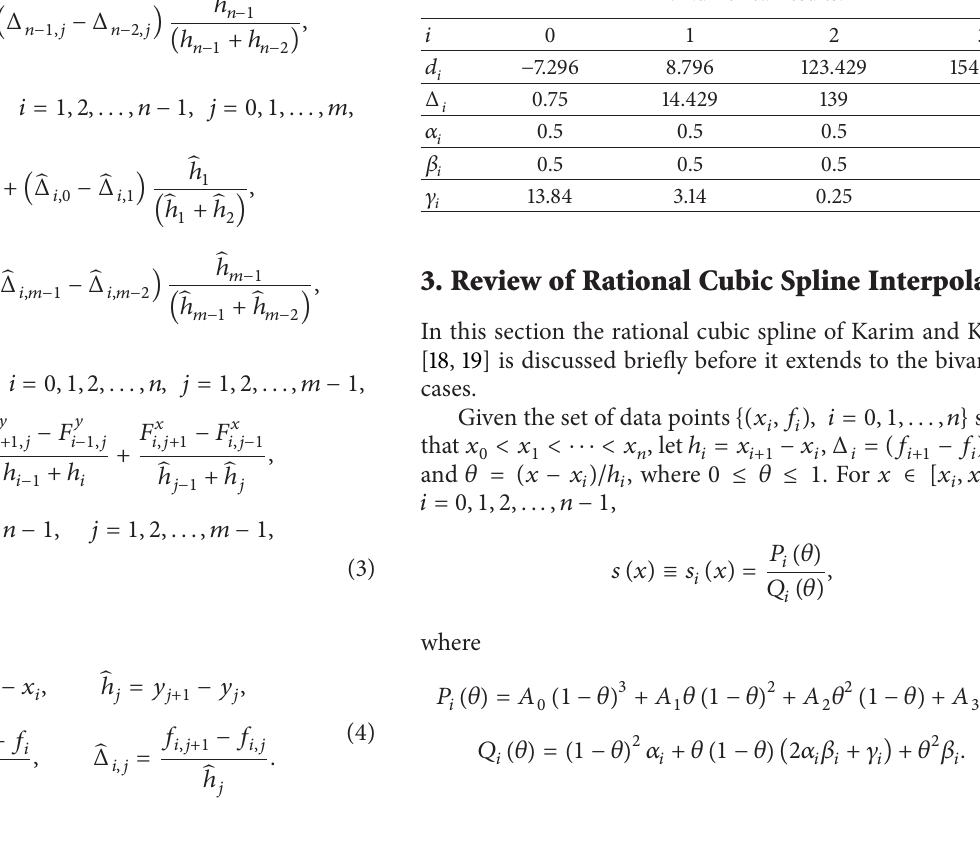
Table 2: Numerical